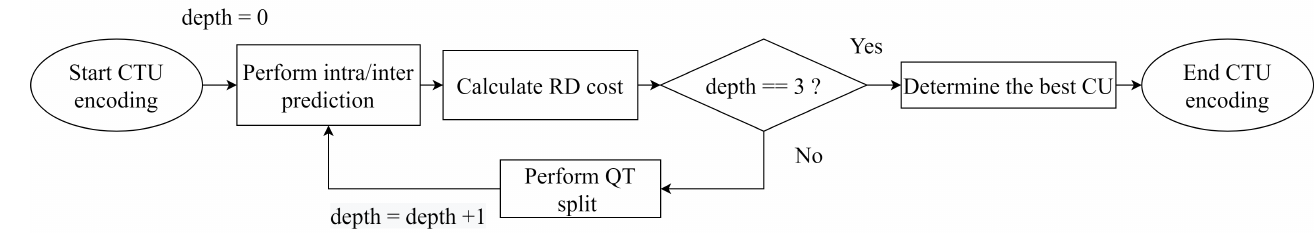
Figure 2. Flowchart of HEVC CTU